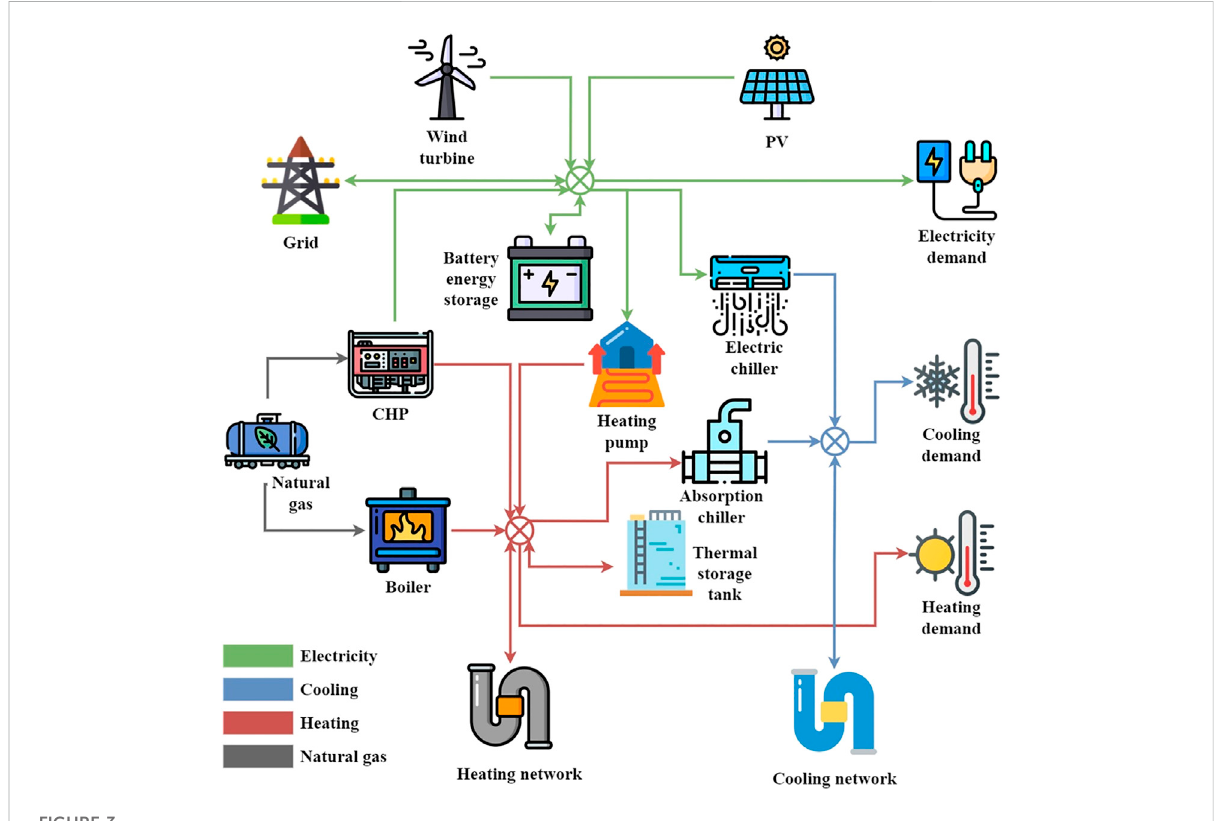
FIGURE 3 Available technology options of